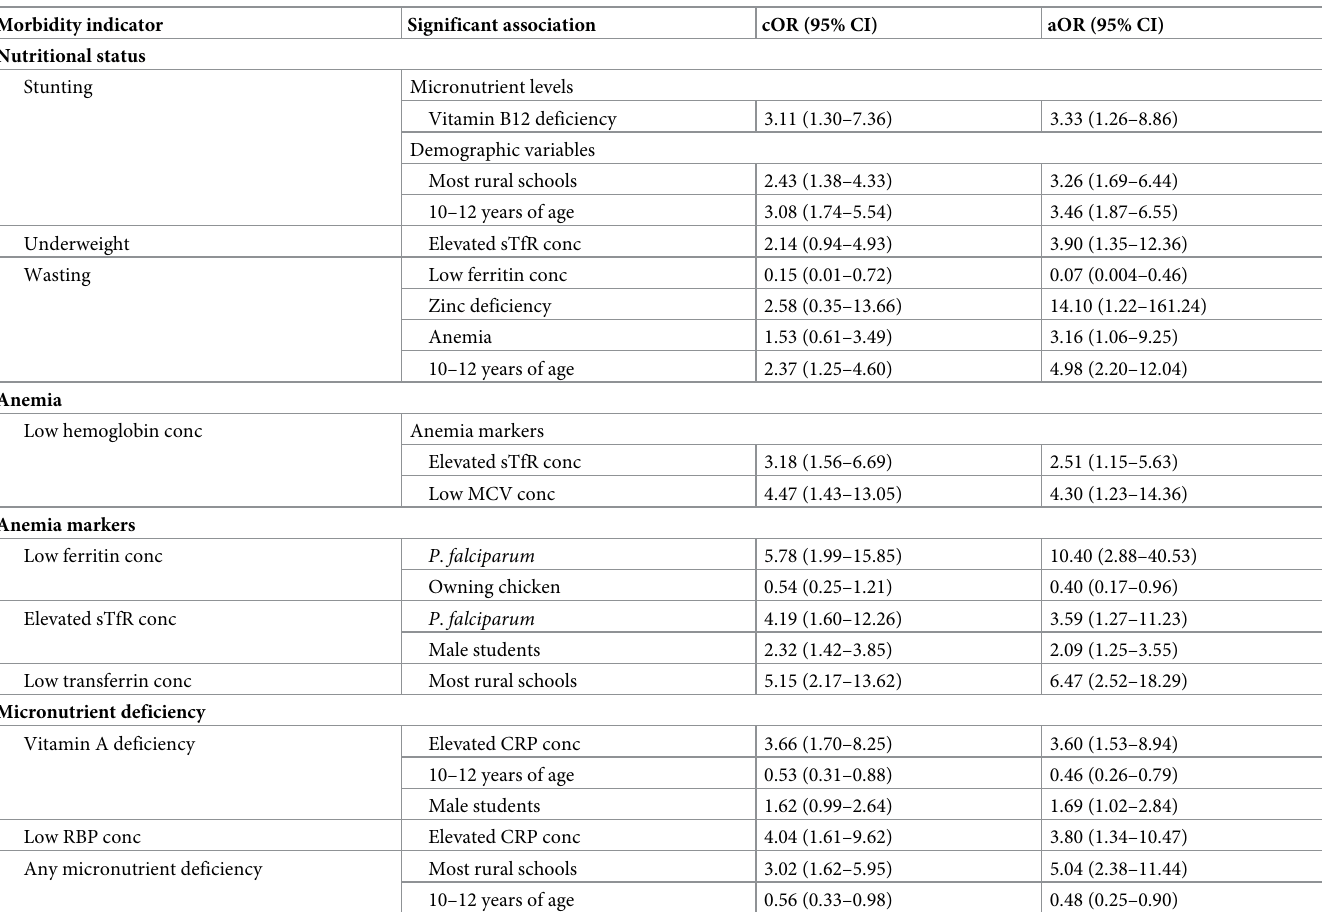
Table 3. Risk factors for nutritional status, anemia and selected micronutrient deficiency in schoolchildren in the Kikwawila and Kiberege wards,